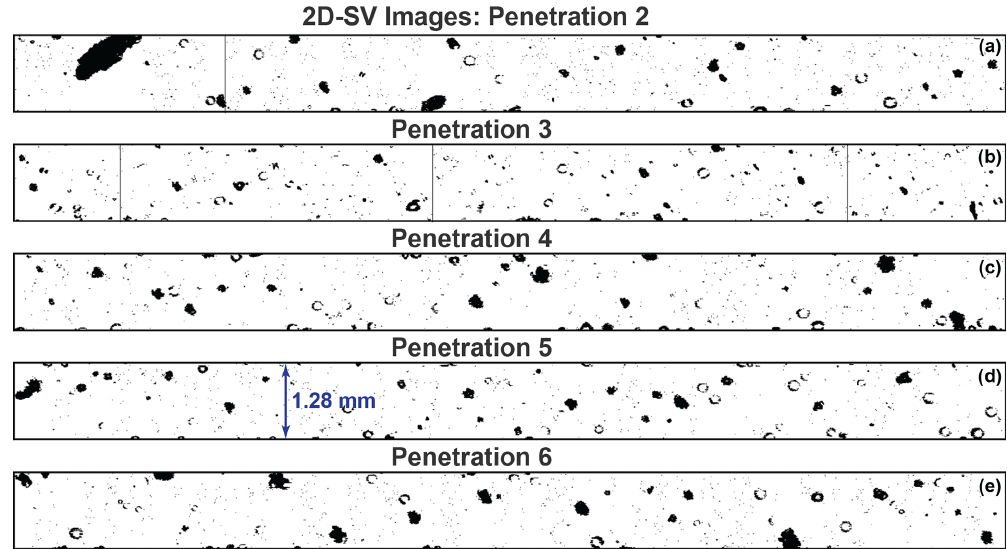
Figure 15. Sampling of 2D-SV particle images for penetrations 2–6 (Fig. 1d, Table 2). Vertical distance of each horizontal strip represents